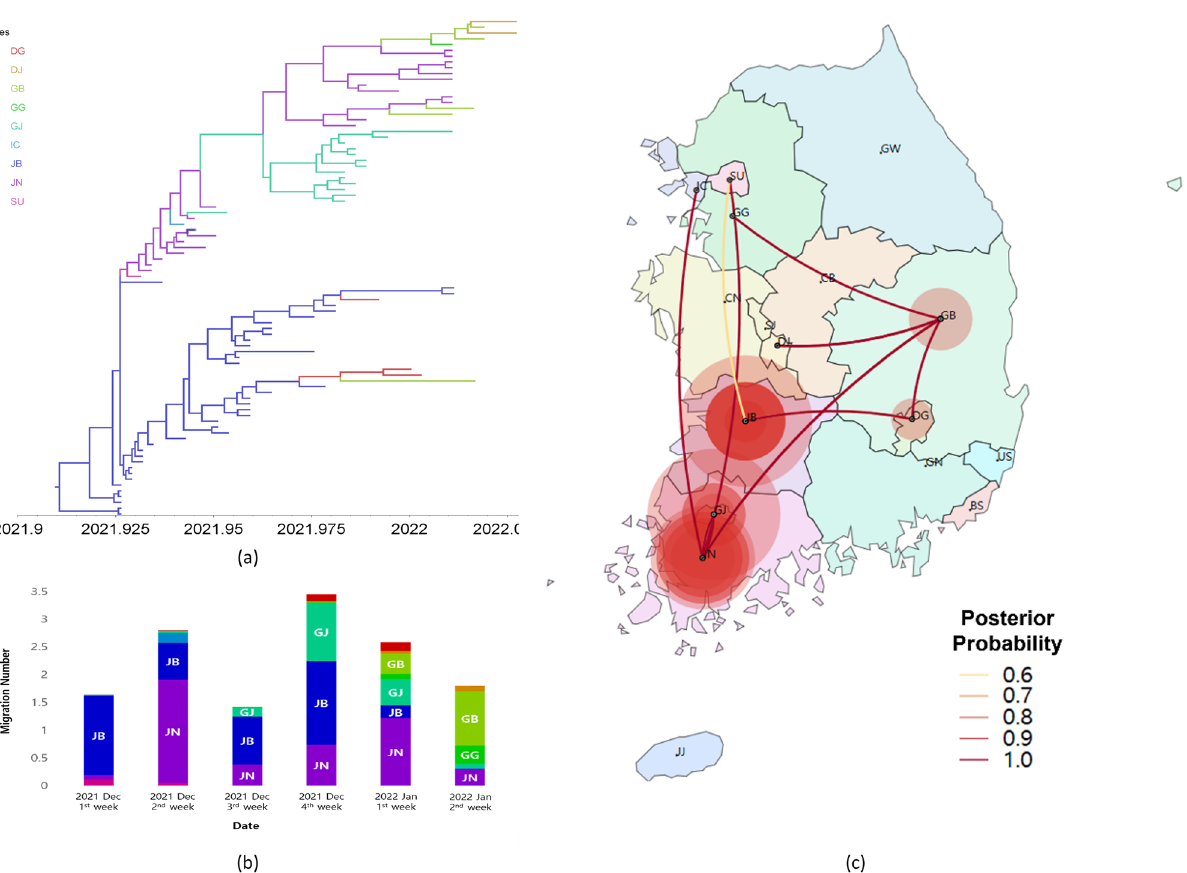
Figure 4. Phylogeographic result of the Kor-O3 subgroup. ( a ) Time-scaled maximum clade credibility tree of the Kor-O3 subgroup. Branches are colored according to their location in South Korea, and the branch thickness indicates the posterior probabilities of the inferred ancestral location. The phylogenetic tree with the virus name is available in Fig. S4. ( b ) Mean number of migration events of the Kor-O3 subgroup from major sources in Korea through time, which was estimated and computed by Bayesian phylogeographic analysis. ( c ) Transmissions of the Kor-O3 subgroup in South Korea visualized by SpreaD3. The color of the lines indicates the posterior probability. The diameters of the circles represent the number of branches maintaining a particular location state in each period. The video of the Kor-O3 transmission history is available on video S3 ( DG Daegu, DJ Daejeon, GB Gyeongsangbuk-do, GG Gyeonggi-do, GJ Gwangju, IC Incheon, JB Jeollabuk-do, JN Jeollanam-do, SU